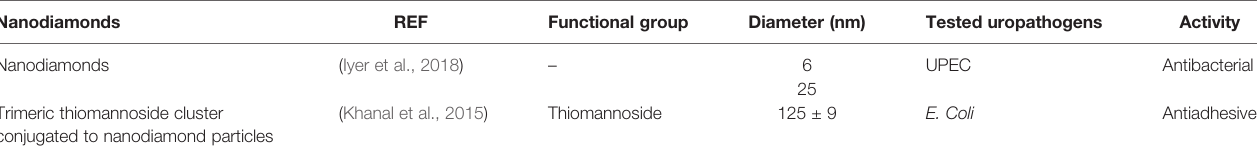
TABLE 2 | Physicochemical characteristics of